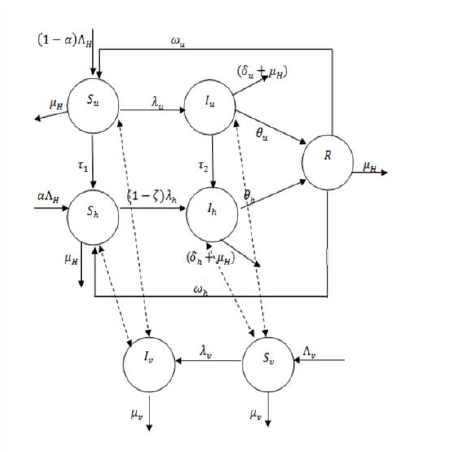
Figure 1. Model Schematic